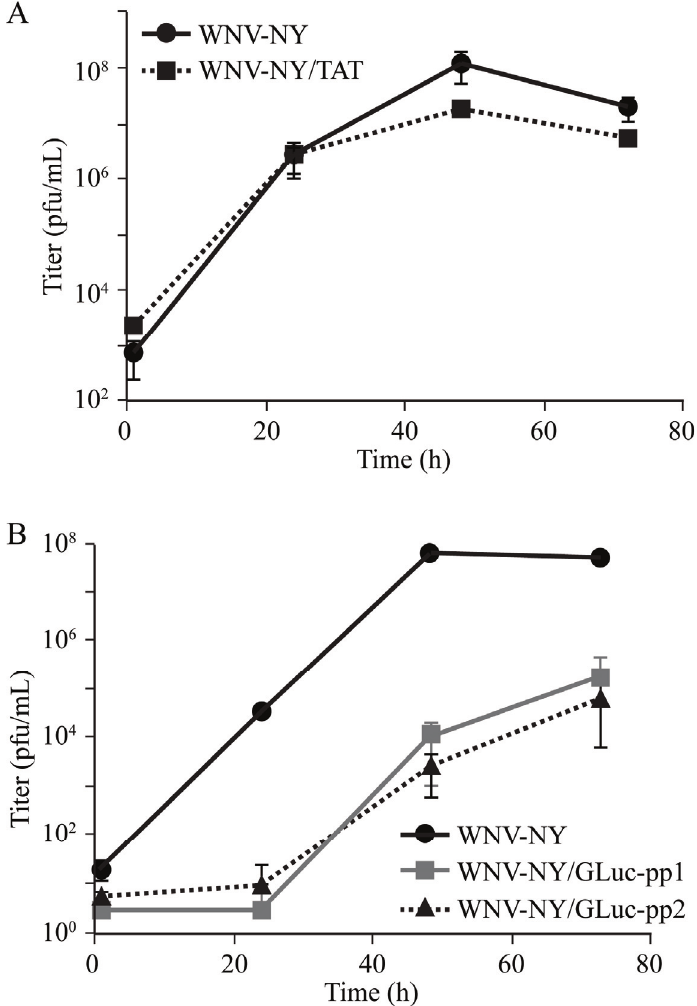
Figure 5. Replication of WNV-NY recombinant viruses. ( A ) WNV-NY/TAT(1-25). Vero monolayers were infected (MOI = 0.05) with WNV-NY or WNV-NY/TAT(1-25) p0; ( B ) WNV-NY/GLuc(ALIC  APC). Vero monolayers were infected (MOI = 0.005) with WNV-NY or WNV-NY-GLuc(ALIC  APC)-pp1 or -pp2 p0. Culture supernatants were collected at the indicated times after infection and infectious particle production determined by plaque assay on Vero cells. Values represent the average number of pfu per mL of supernatant (± standard deviation) from three independent